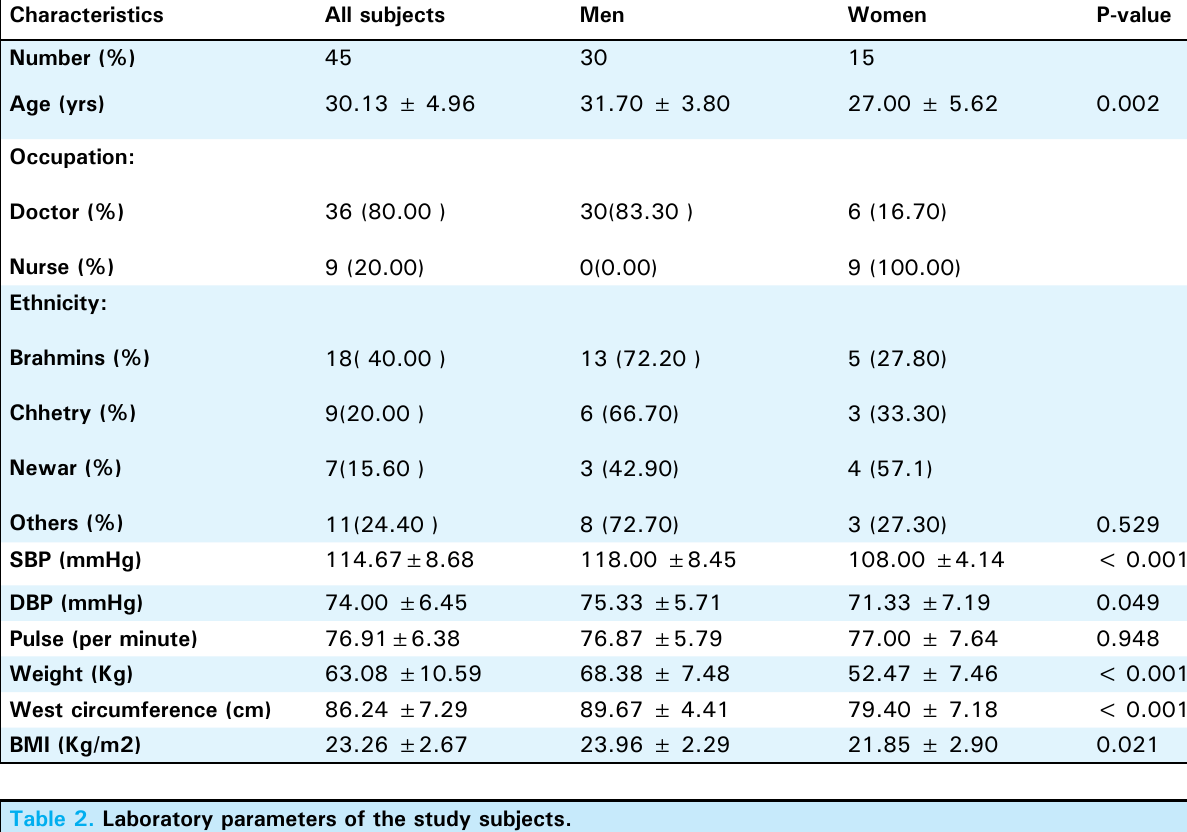
table 1. Demographic profiles and vital parameters of the study subjects.